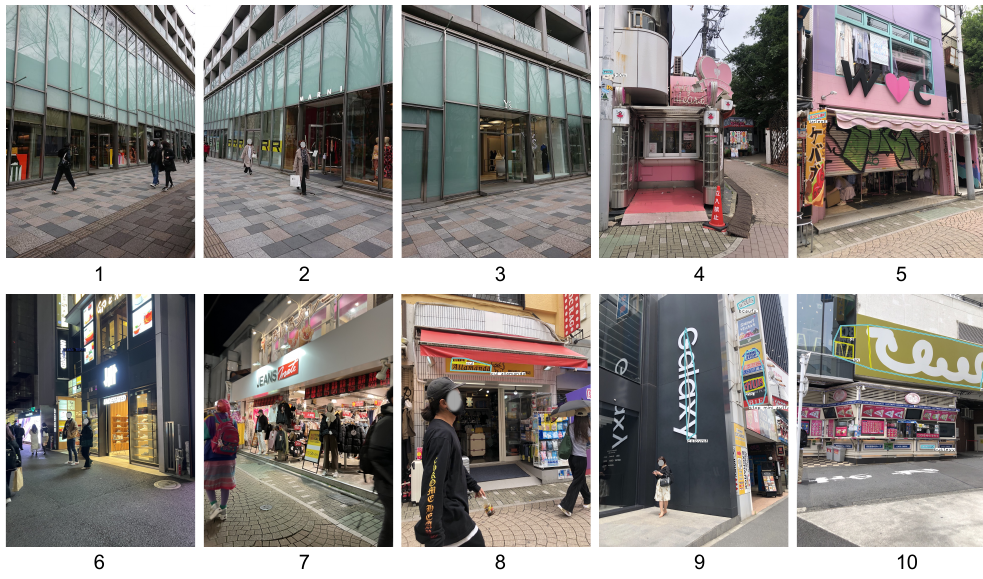
Figure 7. Instances where VPRText fails to accurately detect or recognize the place names. (1,2,3)— oriented views, (4,5)—challenging font styles, sizes, and symbols, (6,7)—oriented illuminated views, (8,9)—vertical texts, and (10)—misleading